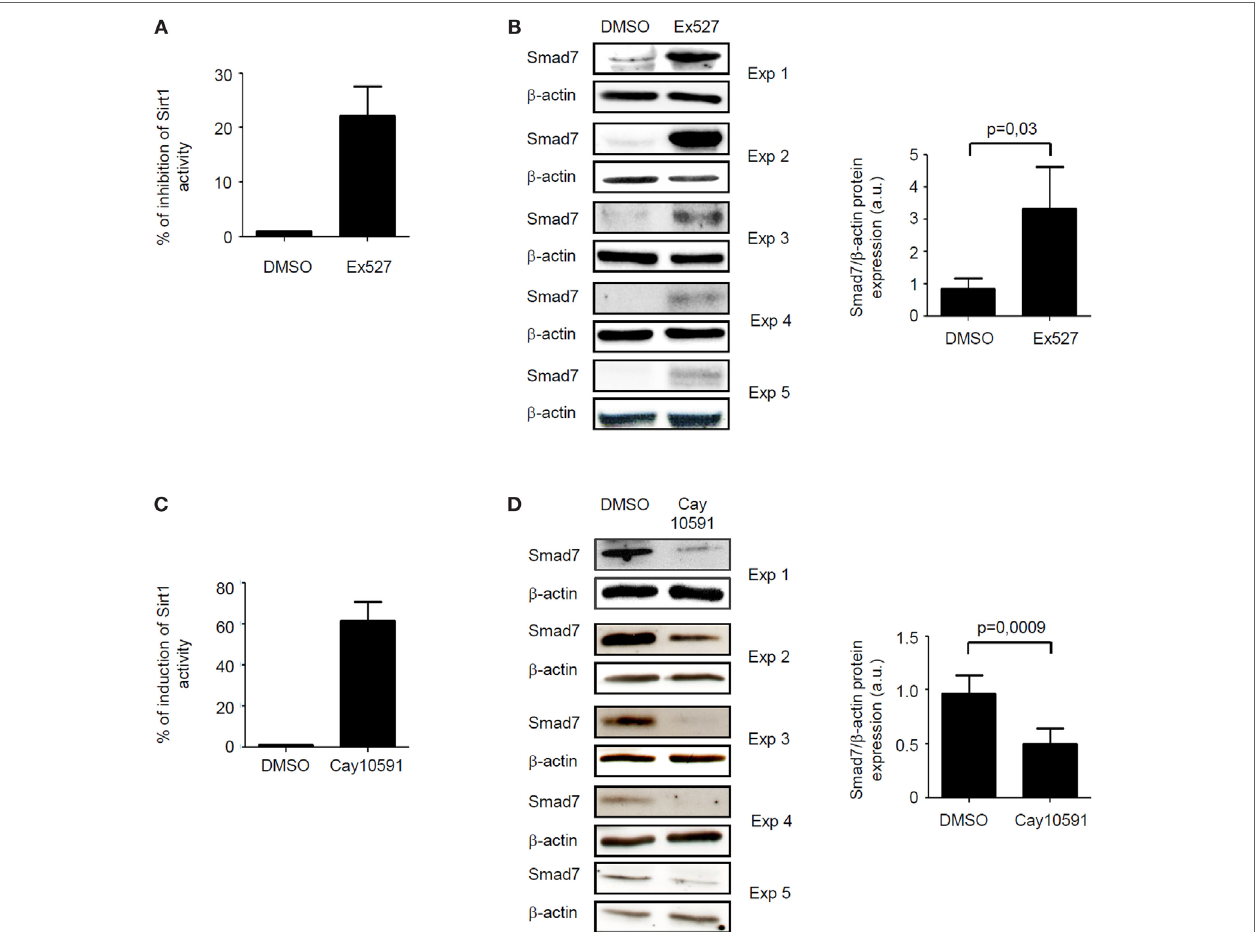
FigUre 3 | Sirt1 regulates negatively Smad7 expression. (a) Sirt1 activity was measured in lamina propria mononuclear cells (LPMC) isolated from five normal controls and cultured in the presence of Ex527 or dimethyl sulfoxide (DMSO). Values are expressed as percentage of inhibition of Sirt1 activity in comparison to DMSO-exposed cells. (B) Western blots showing Smad7 and β -actin in total proteins extracted from control LPMC and cultured in the presence of Ex527 or DMSO. Results of each experiment (Exp) are shown. Right panel shows the quantitative analysis of Smad7/ β -actin ratio as measured by densitometry scanning of Western blots. Values are expressed in arbitrary units (a.u.) and indicate mean ± SEM of all samples. (c) Sirt1 activity was measured in LPMC isolated from five inflammatory bowel disease (IBD) patients and cultured in the presence of CAY10591 or DMSO. Values are expressed as percentage of induction of Sirt1 activity in comparison to DMSO-exposed cells. (D) Western blots showing Smad7 and β -actin in total proteins extracted from IBD LPMC and cultured in the presence of CAY10591 or DMSO. Results of each experiment are shown. Right panel shows the quantitative analysis of Smad7/ β -actin ratio as measured by densitometry scanning of Western blots. Values are expressed in arbitrary units (a.u.) and indicate mean ± SEM of all